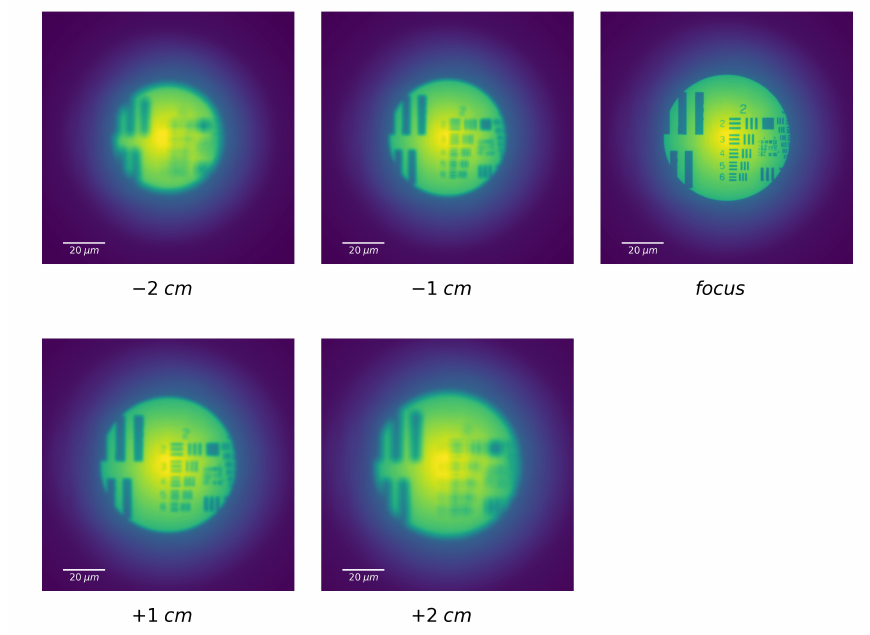
Figure 4. False color numerical images of a USAF 1951 target are recorded at various distances from the image plane in focus (called focus). The recorded distance is referred to the focal plane under each image. The focus is taken as the origin, and the negative and positive signs, respectively, represent the directions closer and further to the FZP. The FZP has the same parameters for Figure 2. The object to FZP distance is 3 f and leading to the creation of an image on focus is at 1.5 f . Each image dimension is 120 × 120 µ m 2